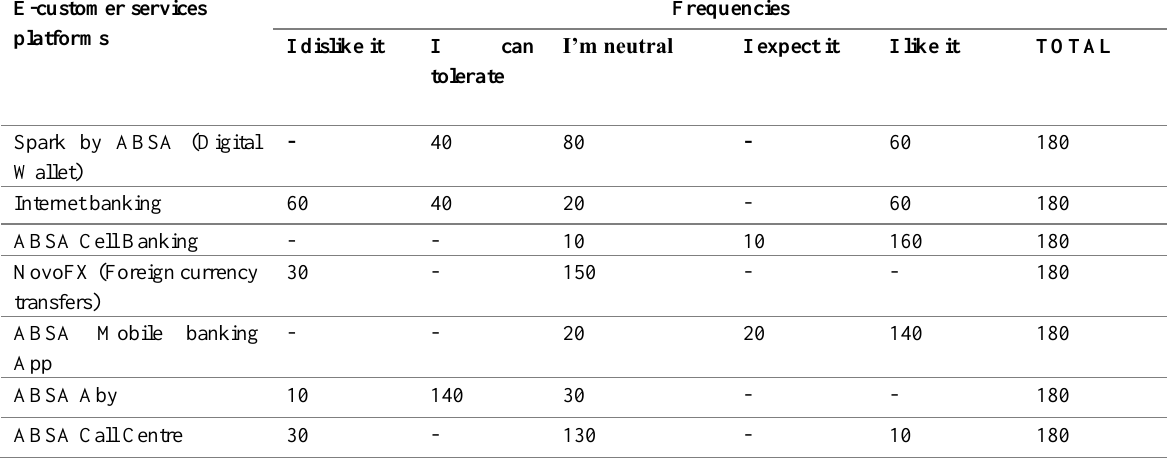
Table 2: Feelings of Customers Towards E-Customer Service Platforms at ABSA